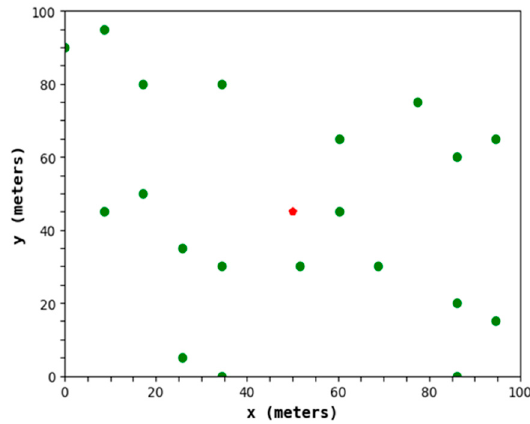
Figure 8. A CH distribution diagram of the protocol in this paper.